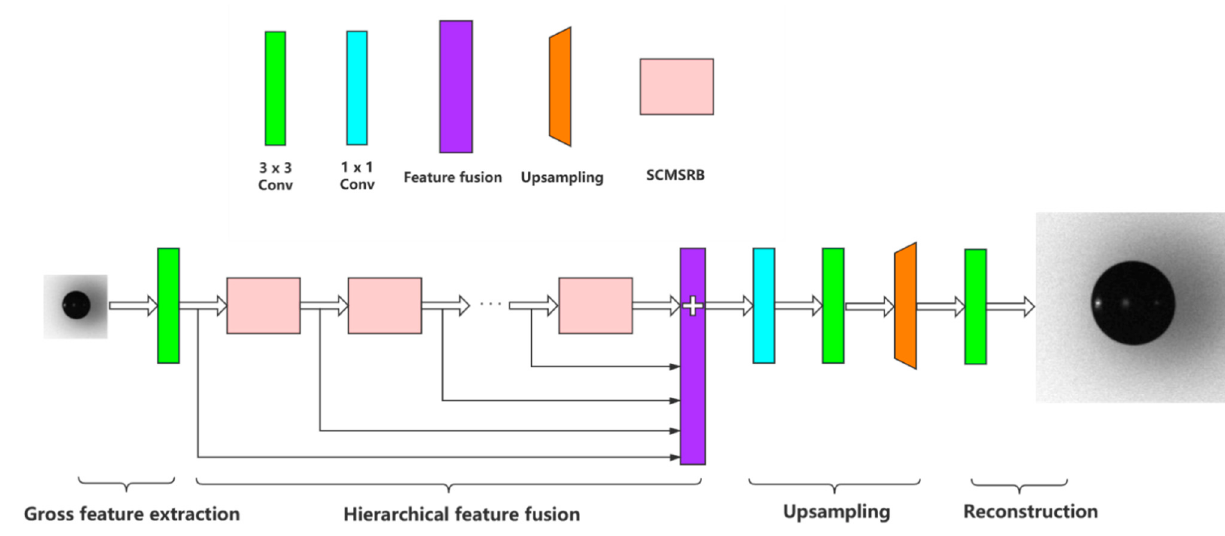
Figure 1. The overall structure of the single-core cascaded residual multi-scale feature fusion network.